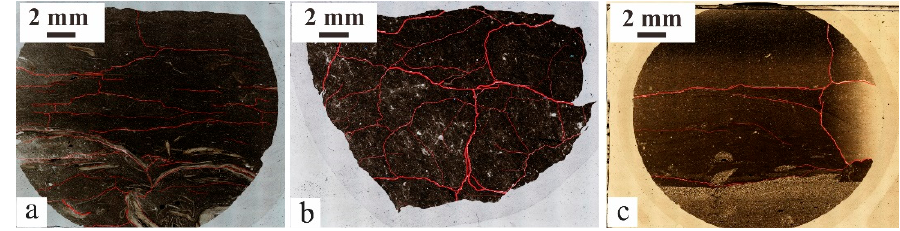
Figure 2. Fractures (red areas) in mosaic images. ( a ) Yuanlu 4 well, 3747.18 m, ( b ) Yuanlu 176 well, 4141.85 m, and ( c ) Yuanba 122 well, 3560.35 m.